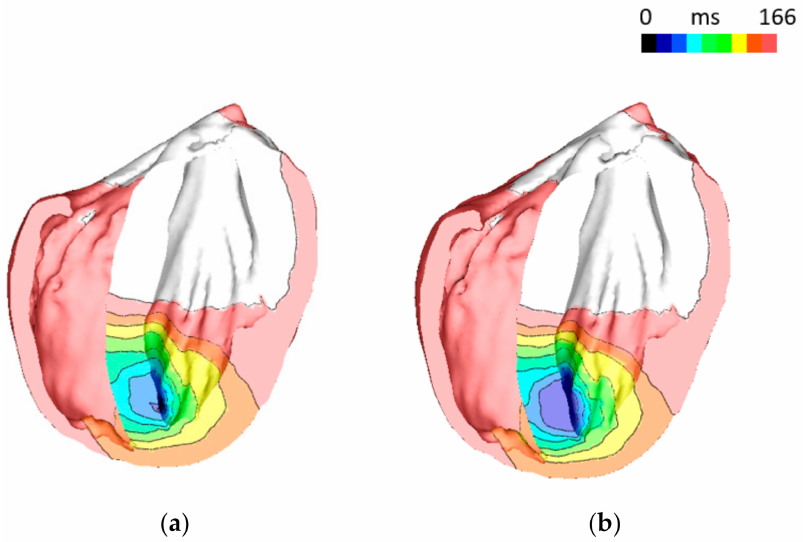
Figure 7. The APD distribution at different extracellular potassium concentrations after S1 stimula- tion. The extracellular potassium concentrations of were ( a ) 9 mM and ( b ) 12 mM,